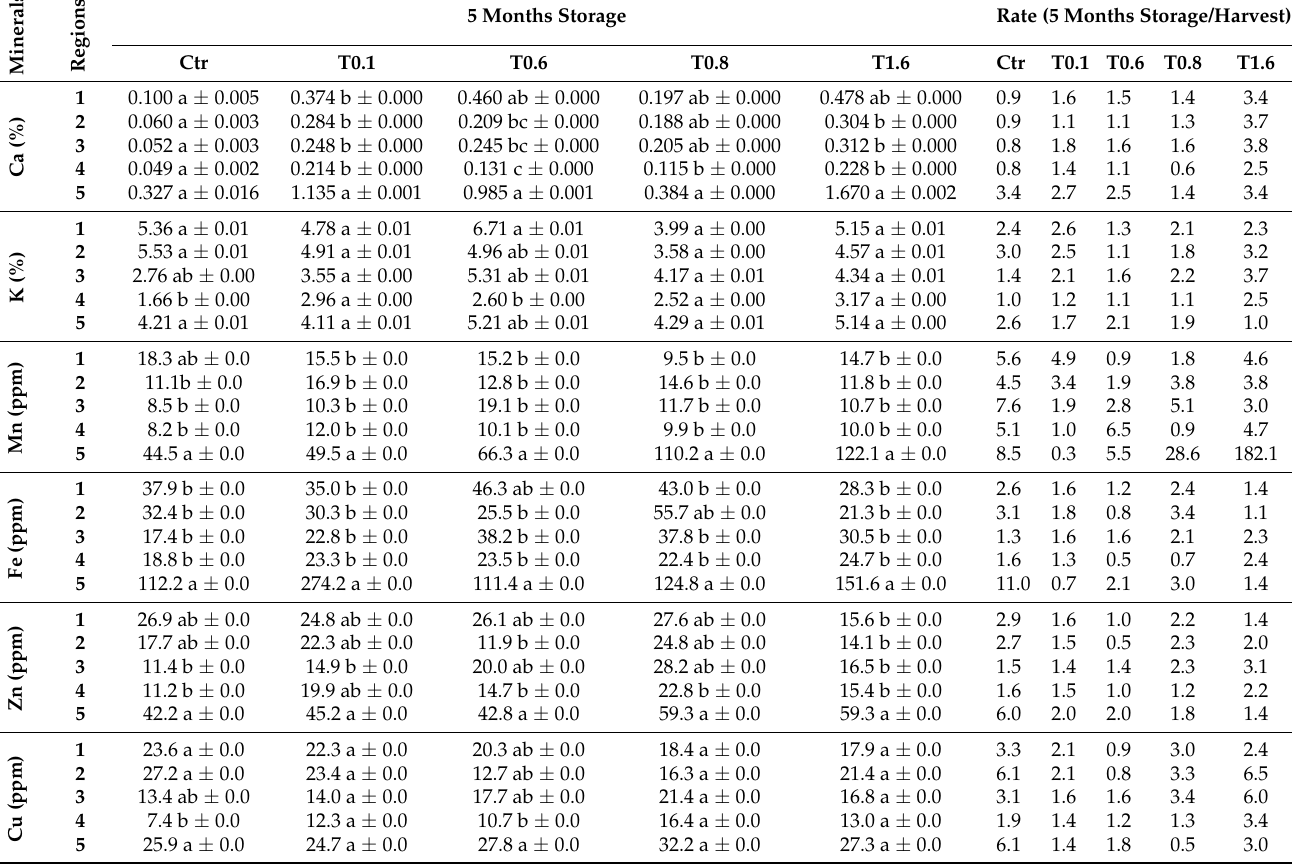
Table 1. Average ± S.E. of Ca, K, Mn, Fe, Zn and Cu from Rocha pear fruits by region (from center to epidermis, zone 1 to 5, respectively), after 5 months of storage. Treatments Ctr, T0.1, T0.6, T0.8 and T1.6 correspond to the control and initial foliar spraying with 0.1 and 0.6 kg · ha − 1 Ca(NO 3 ) 2 and 0.8 and 1.6 kg · ha − 1 CaCl 2 , respectively. Letters a, b and c represent significant differences among regions for each